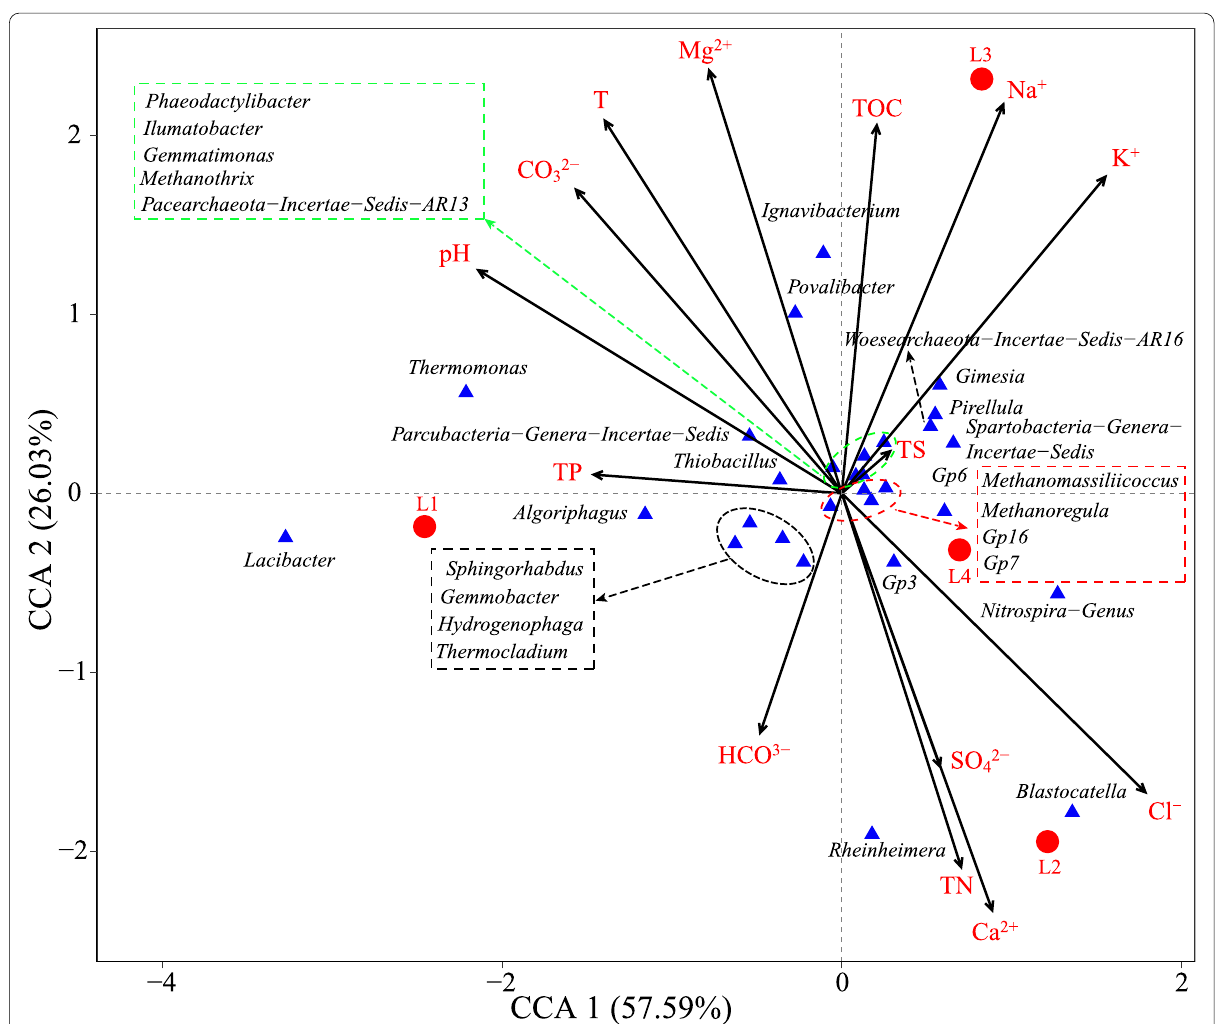
Fig. 4 Canonical correspondence analysis (CCA) showing the relationships among dominant genera and hydrochemical variables in LGL. Samples are indicated by red circles, while genera are indicated by blue triangles, and environmental variables are indicated by arrows. TS, TOC, TN, and TP correspond to total salinity, total organic carbon, total nitrogen, and total phosphate,